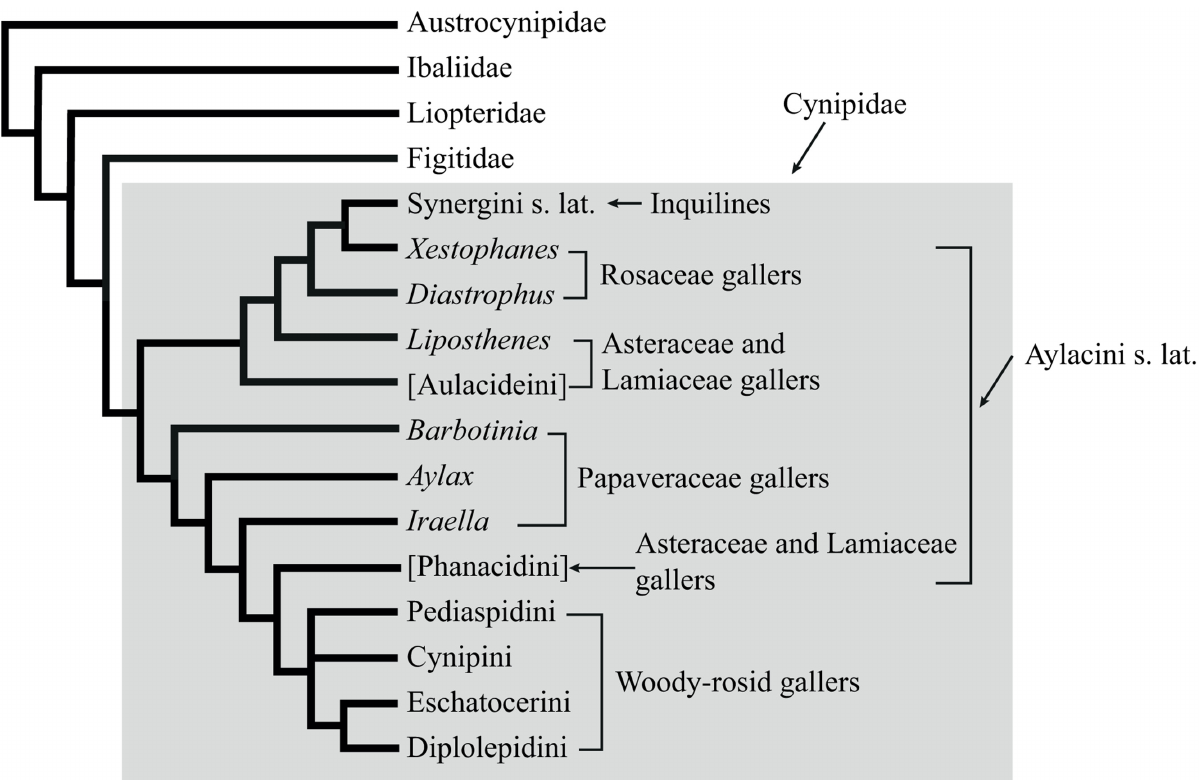
Fig 1. Relationships among gall wasps and their insect-parasitic relatives based on previous analyses of adult morphology [7, 14, 27, 28, 34]. Tribal concepts introduced in the current paper are placed in square brackets. Note that the genus Liposthenes was placed outside the Aulacideini in these analyses, but subsequent analyses have shown that it should be placed inside